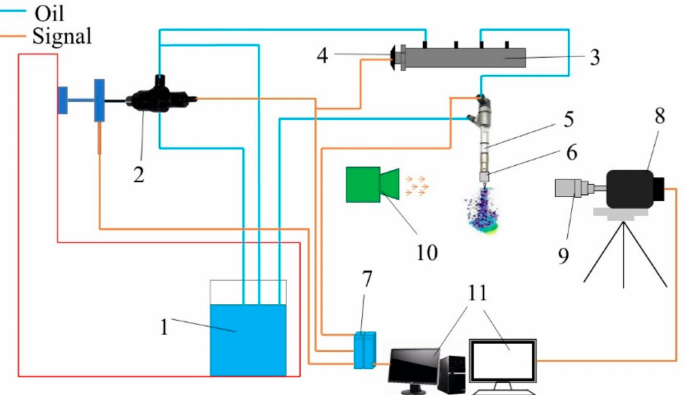
Figure 1. The experimental visualization platform. 1. Oil tank; 2. High-pressure oil pump; 3. High- pressure common-rail pipe; 4. Pressure sensor; 5. Fuel injector; 6. Experimental nozzle; 7. Electronic control unit (ECU); 8. High-speed framing camera; 9. Long focal distance microscope; 10. LED light; 11. Computer.